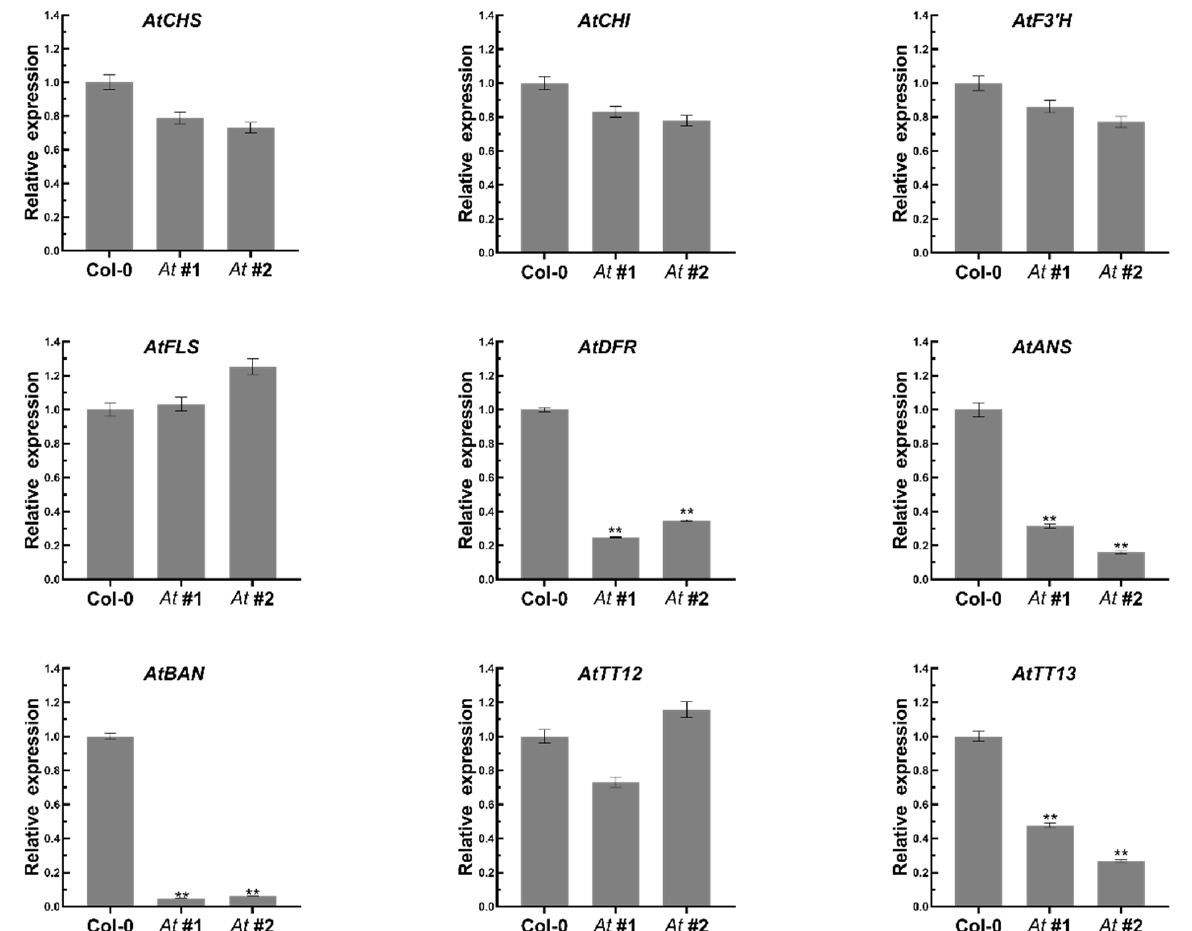
Figure 5. The expression level of enzyme genes in the flavonoid metabolic pathway in Arabidopsis overexpressing FtMYB3 (At #1 and At #2) compared with those in Col-0. The mRNA abundances of 9 genes were monitored by qRT-PCR in the 4-week-old seedings of Col-0, At #1, and At #2, respectively. The 2 − ∆∆ CT method was used to evaluate the relative expression, and AtActin2 was used as a reference gene. Error bars represent ± SDs. ** means extremely significant difference at p < 0.01 level.